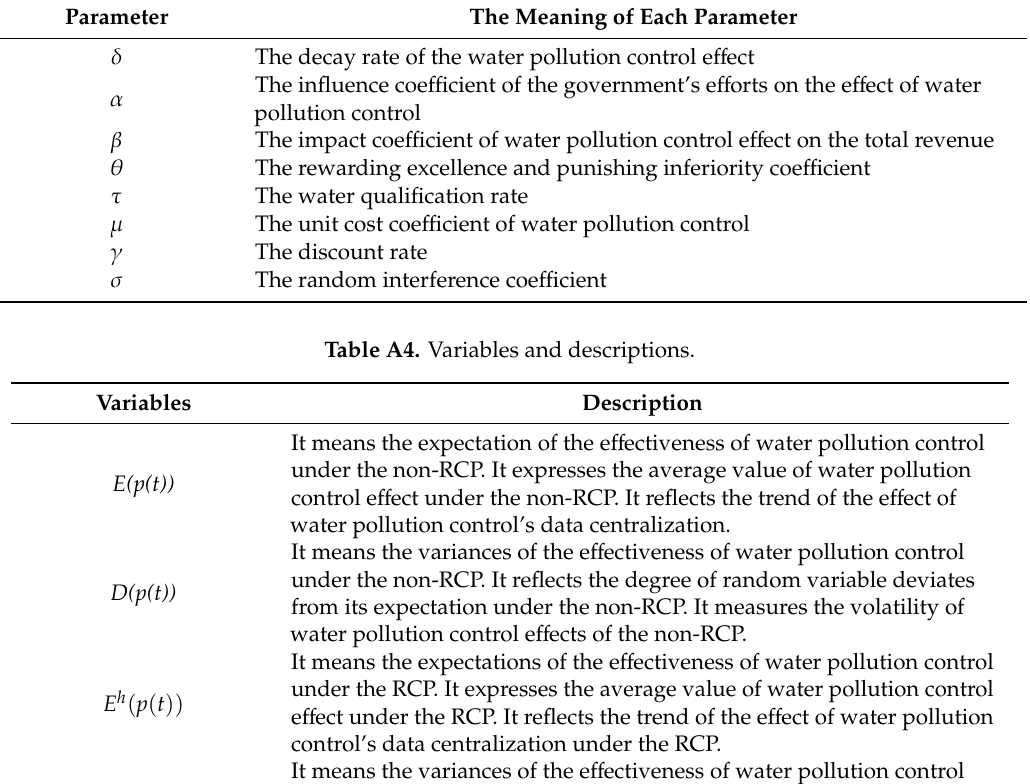
Table A3. The meaning of each parameter.